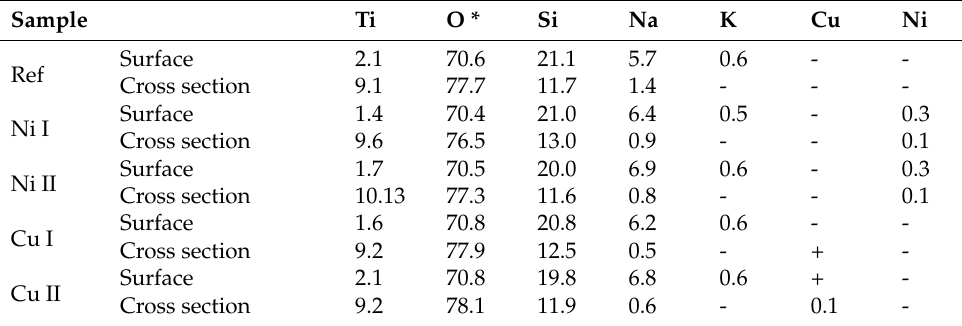
Table 2. Layer content in terms of atomic %, examined using